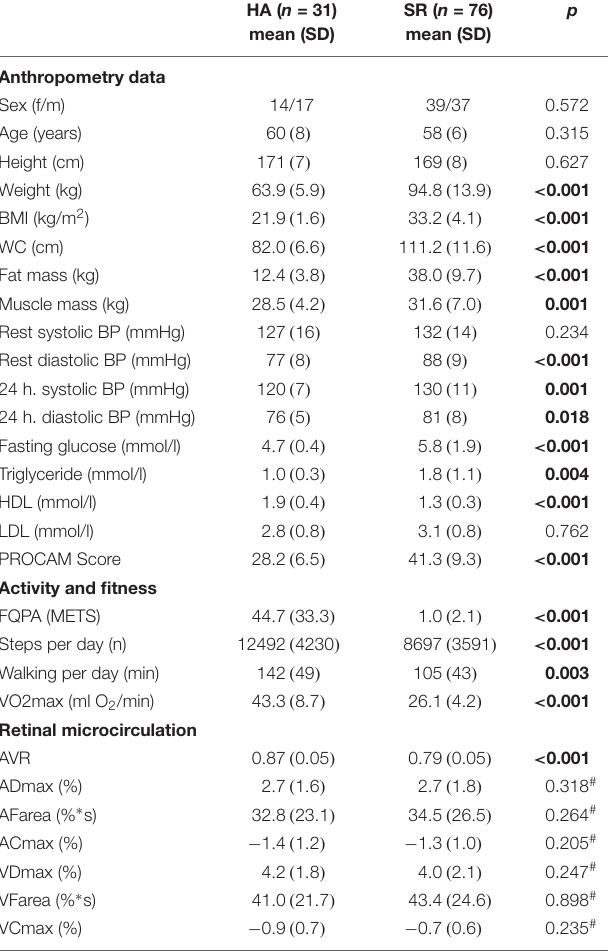
TABLE 4 | Group differences between healthy active and sedentary individuals with increased CV